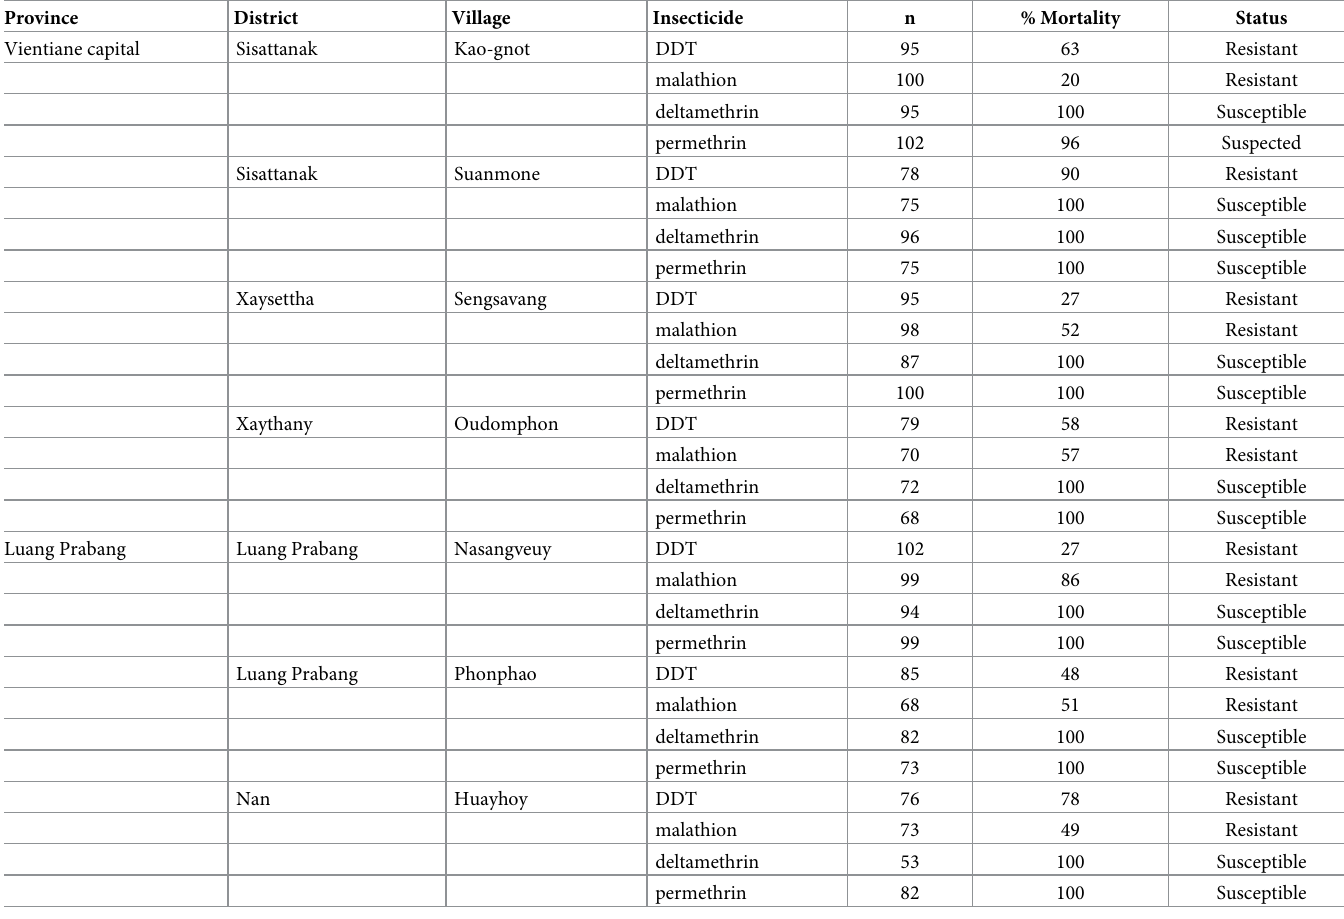
Table 2. Resistance status of adult Aedes albopictus to DDT, malathion, deltamethrin and permethrin according to WHO criteria [72, 74, 76]. Province